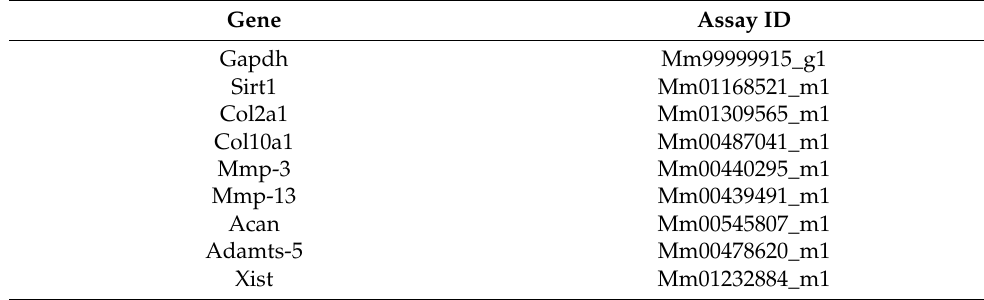
Table 2. Primers used for real-time